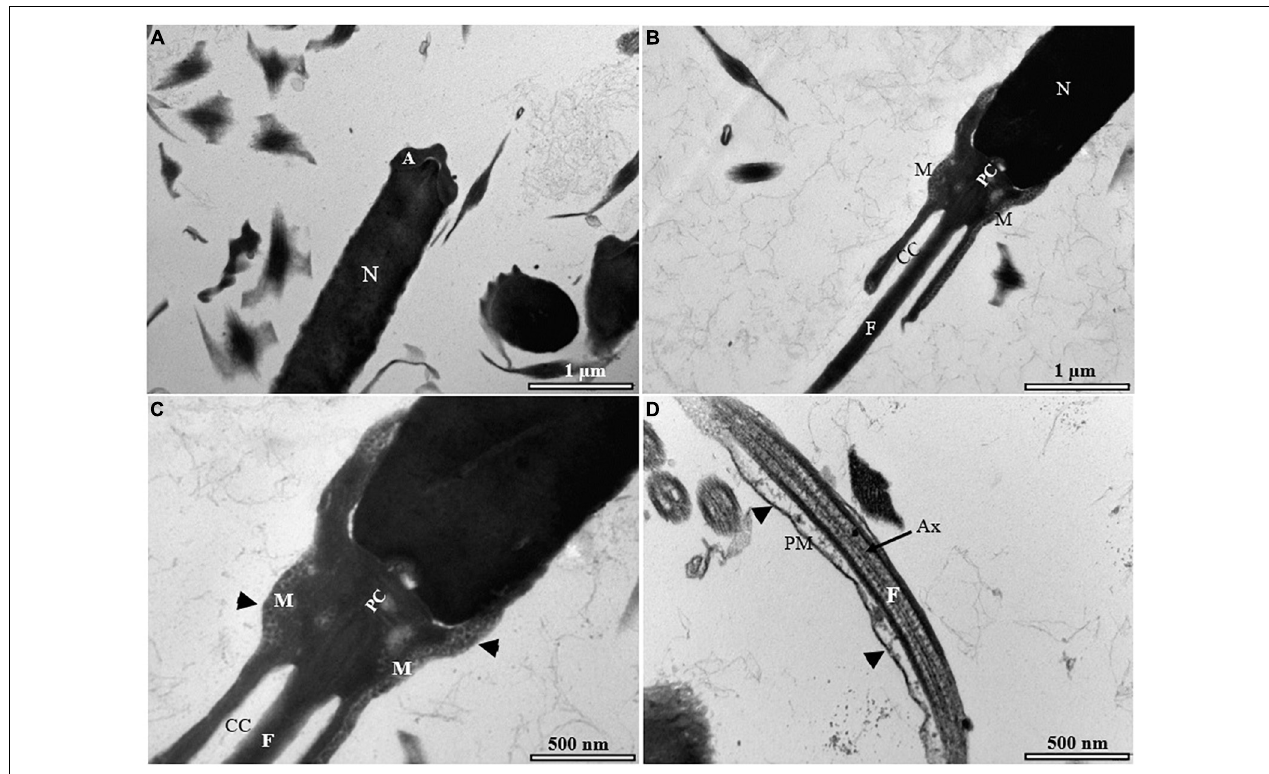
FIGURE 8 | Transmission electron micrographs of cryopreserved spermatozoon in sterlet. (A) Longitudinal sagittal section of cryopreserved spermatozoon showing different parts of the cell; (B) longitudinal section of cryopreserved spermatozoon with some abnormalities in the midpiece; (C) higher magnification of spermatozoon midpiece showing weakening of the midpiece, and particularly, loss of the mitochondria envelope (black arrowheads indicate the mitochondrial crests); (D) higher magnification of spermatozoon flagellum showing detachment and rupture of the plasma membrane of the flagellum (black arrowheads). A, acrosome; Ax, axenome; CC, cytoplasmic channel; F, flagellum; M, mitochondrion; N, nucleus; PM, plasma